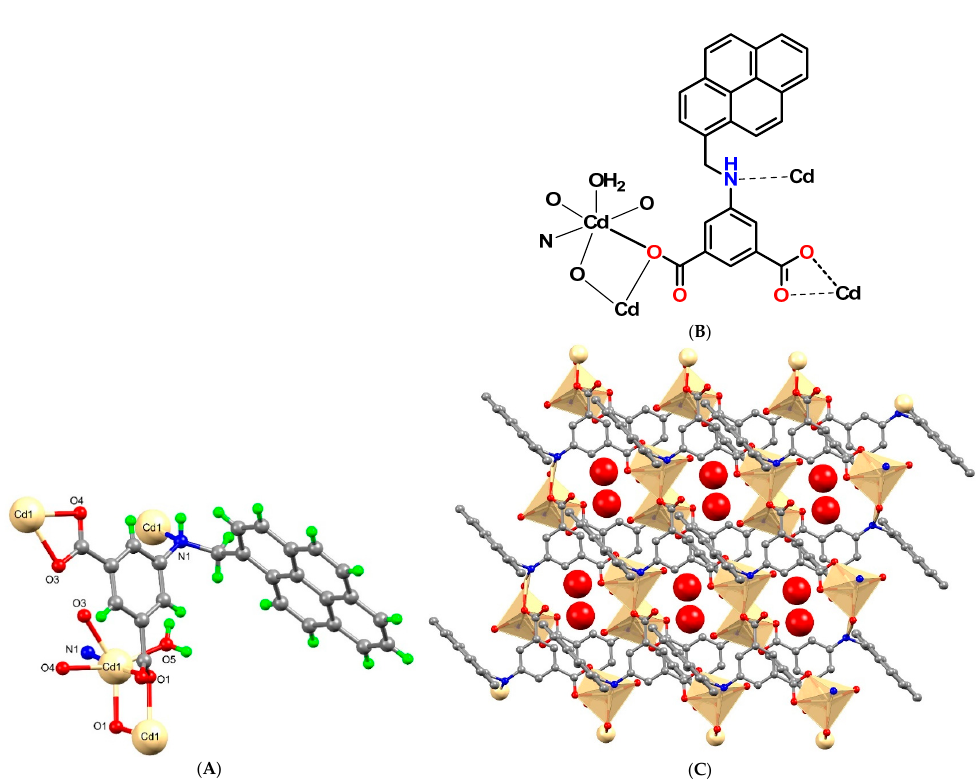
Figure 4. ( A ) Molecular structure of framework 2 . ( B ) Schematic representation of framework 2 . ( C ) Two-dimensional structure of framework 2 (the hydrogen-bonded water molecules are indicated as red balls).